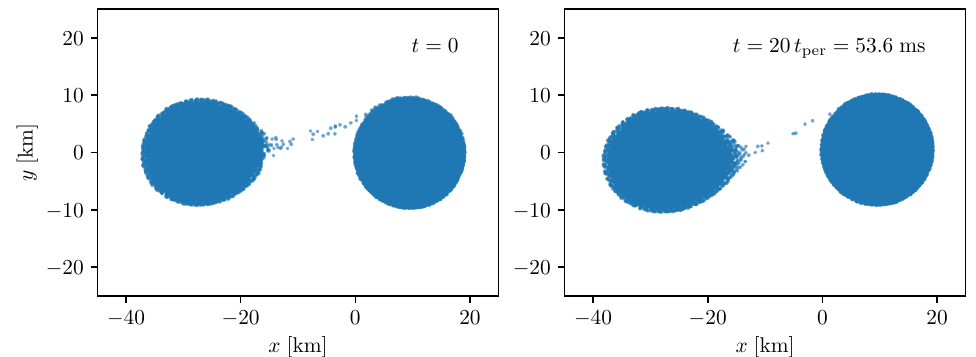
Figure 5. Calculation of a binary system evolution with the same parameters as in Figure 4, but with a 0 = 36